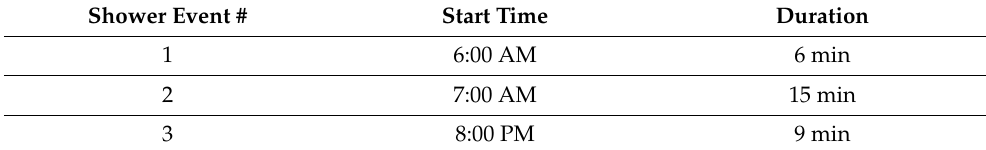
Table 2. Start times and durations for shower events used in the